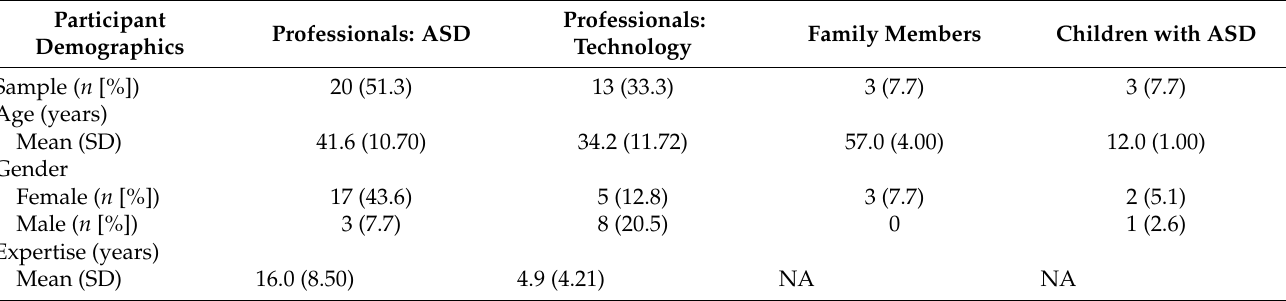
Table 1. Characteristics of